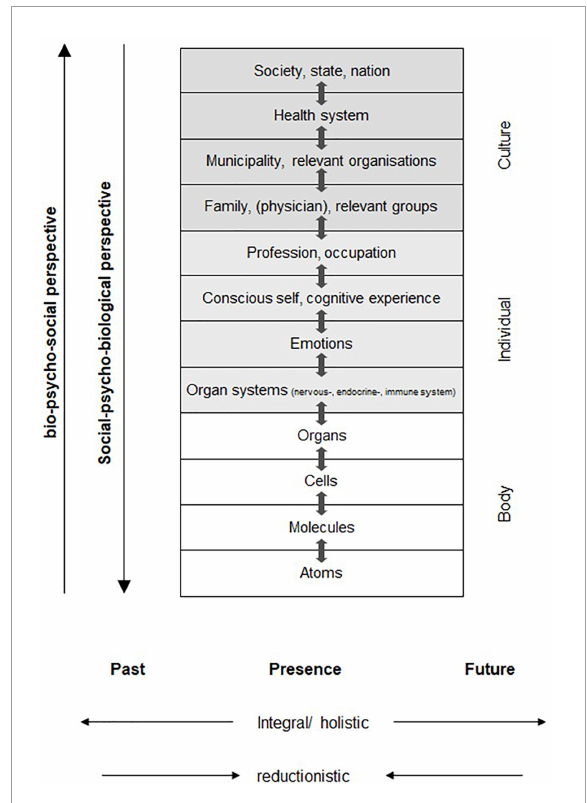
FIGURE3 Biopsychosocial model of illness and health in line with (47,